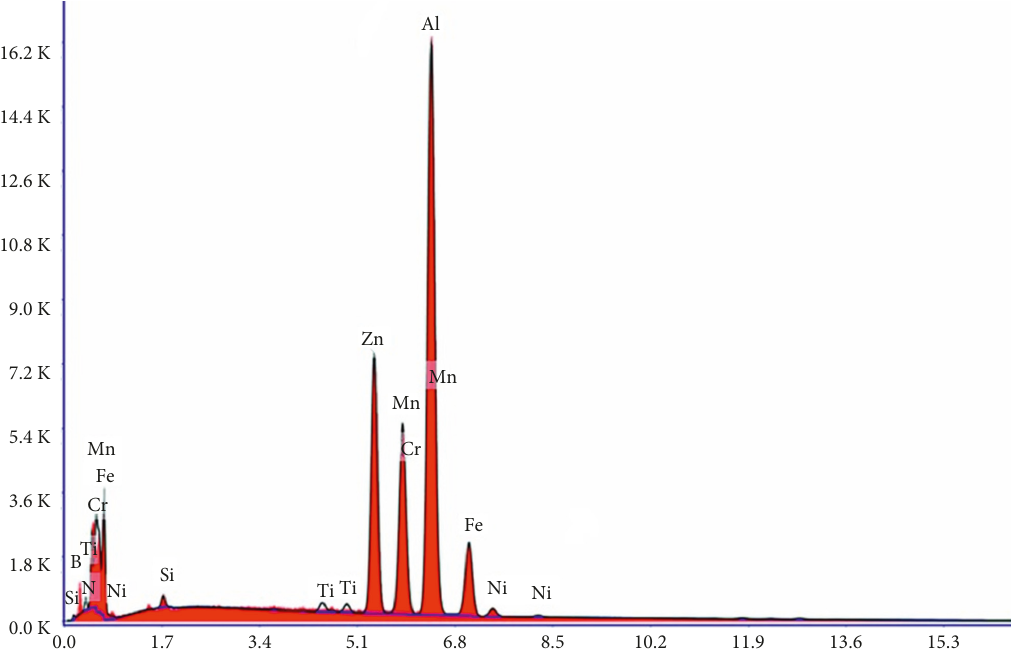
Figure 3: EDAX of worn surface of AA7050